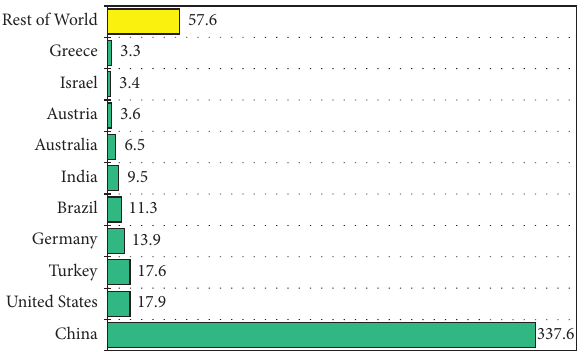
Figure 2: Global solar water heating capacity 2018 (in GW), by country [31].